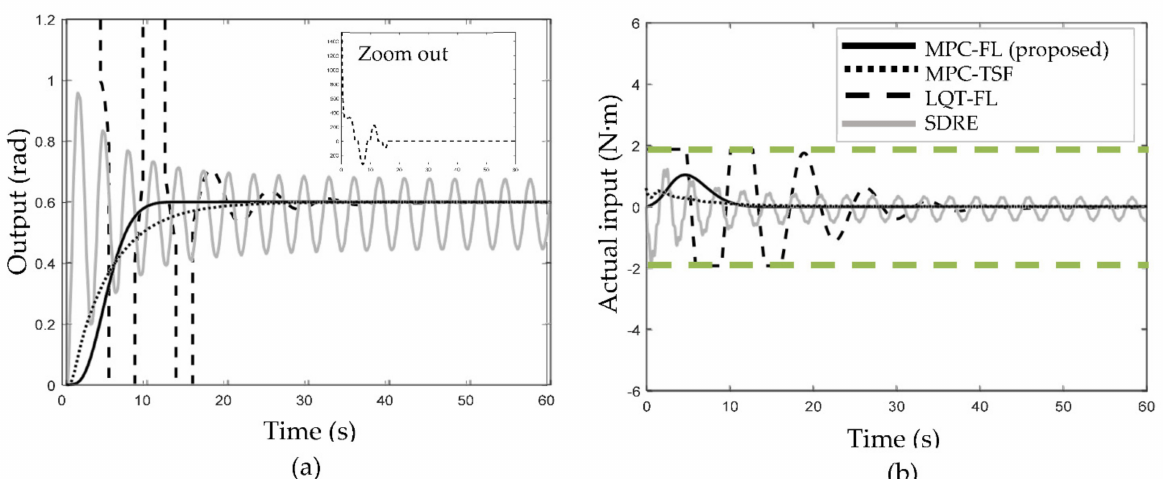
Figure 6. Flexible-joint mechanism by applying the four control schemes with input constraints ± 1.8 N · m: ( a ) output responses; ( b ) input signals.